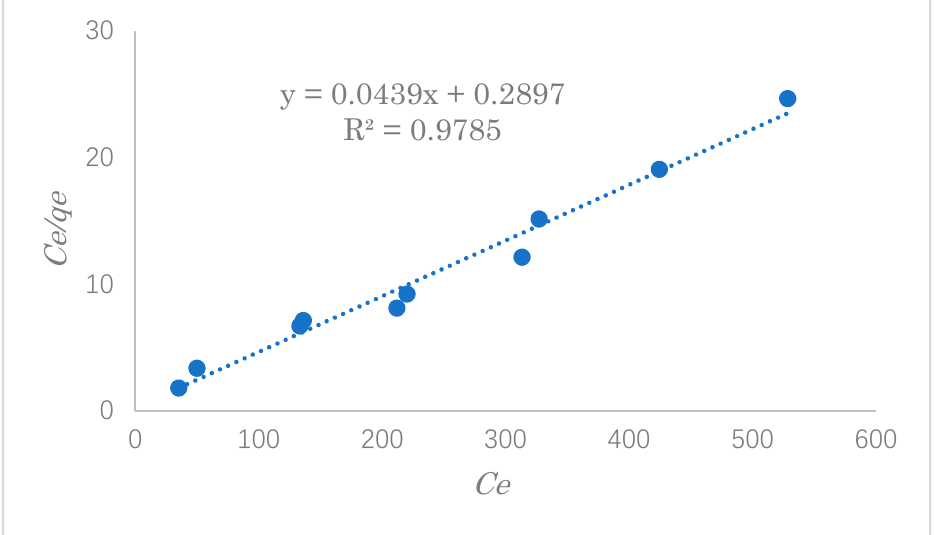
Figure 13. The Langmuir isotherm for the adsorption of SDS by modified cellulose.